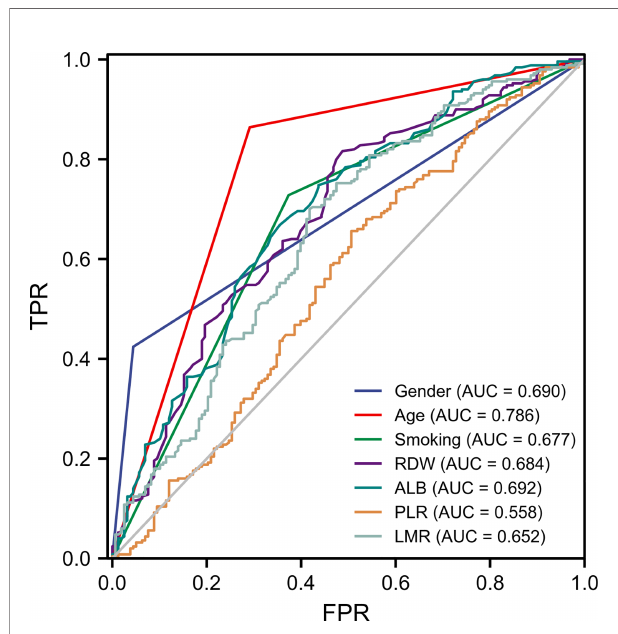
FIGURE 3 | ROC curve analysis of seven candidate diagnostic